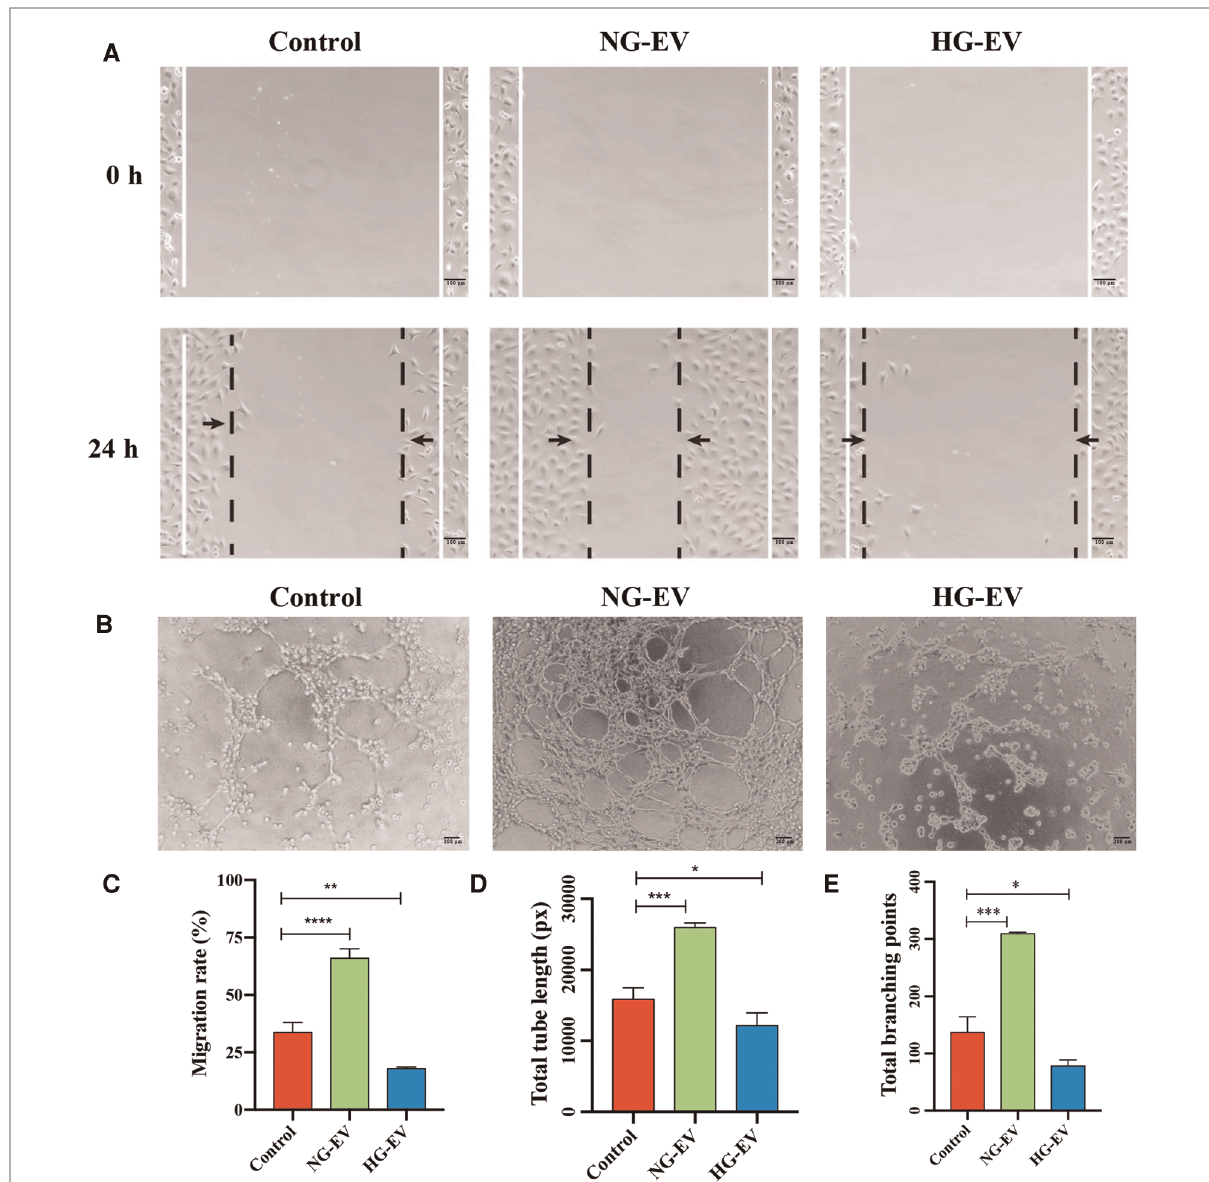
FIGURE 3 The effects of EVs on HUVECs migration and tube formation. ( A ) 0 and 24 h after scratch. ( B ) The images of tube formation of HUVECs in each group. ( C ) The statistical analysis of wound closure area ( n =5). ( D,E ) Quantitative analysis of tube formation